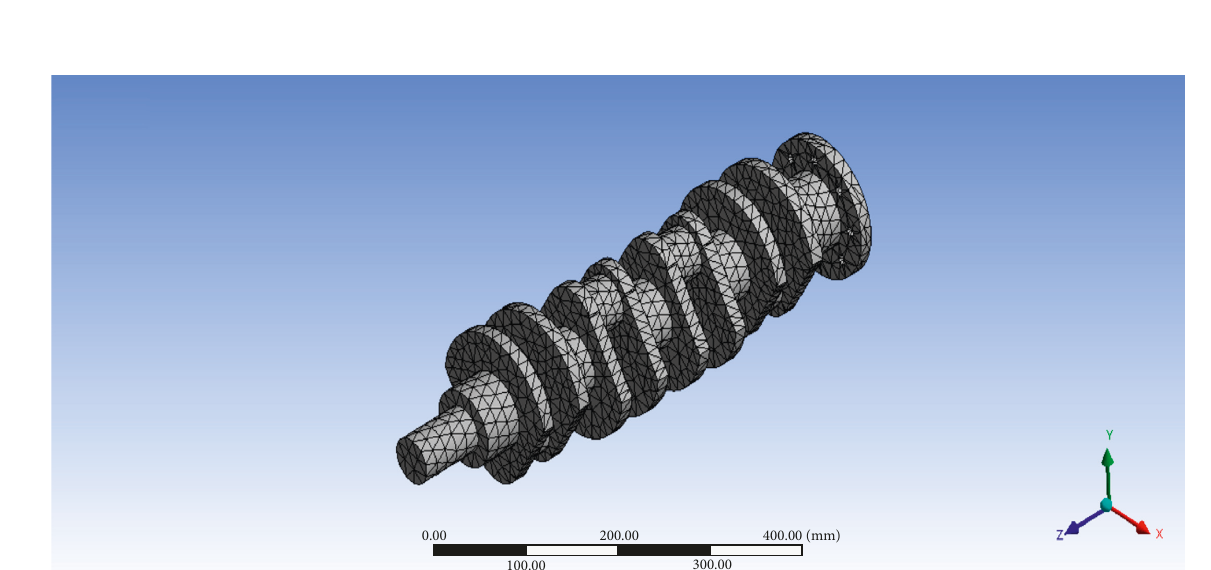
Figure 3: 3D model of a meshed crankshaft created in ANSYS